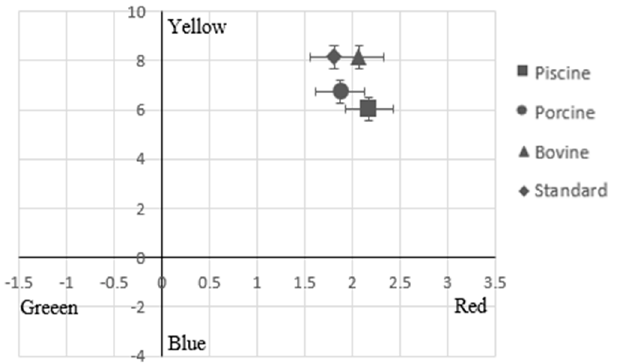
Figure 6. Colour a*, b* values of the bioplastics generated with piscine, porcine, and bovine gelatine and potato starch. Values represent an average of n = 3; error bars represent standard deviation.